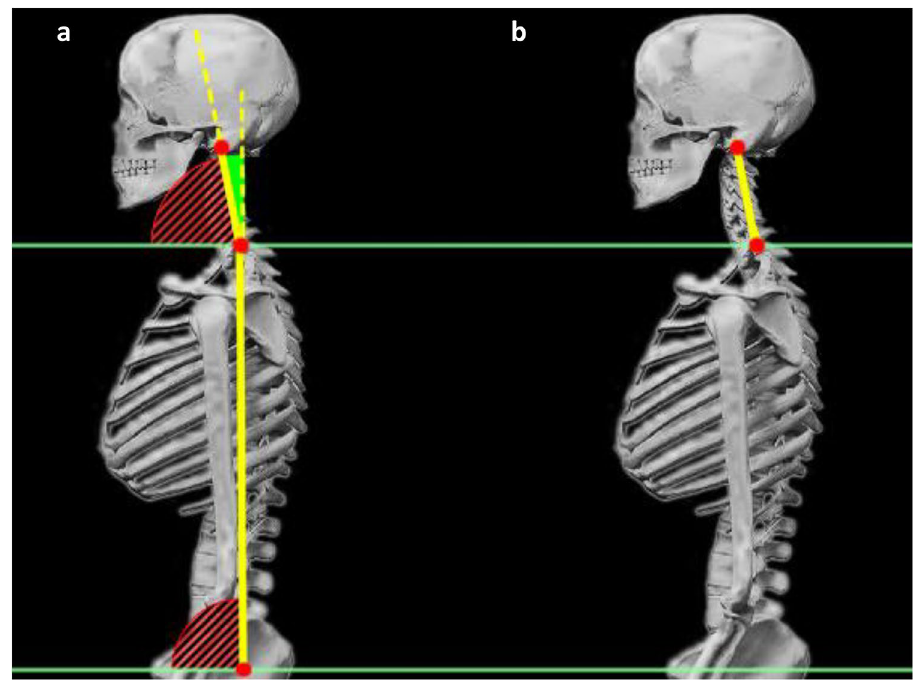
Fig. 3 The Motion Monitor composite skeleton. a Digi- tized points for atlanto-occip- ital (AO) joint, C7/T1 vertebral joint, and L5/S1 vertebral joint are shown in red. Dependent measure of neck flexion angle is shown in solid green, and b neck length (distance between AO and C7/T1) is shown in